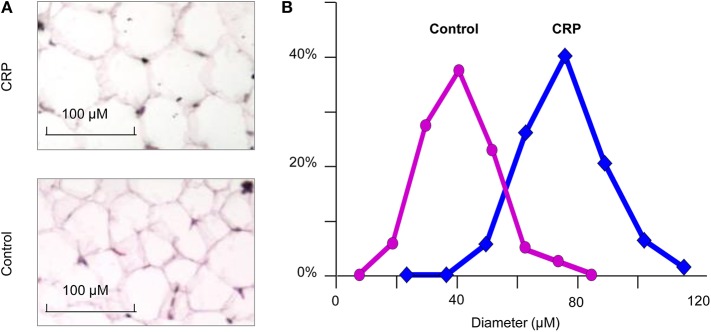
The size of adipocytes in the CRP and control rats. (A) Histochemical staining of fat tissue (n = 6, 16-week-old, male); (B) Comparison of transgenic rats and control rats on the size of adipocytes. *p = 4.5E-30.